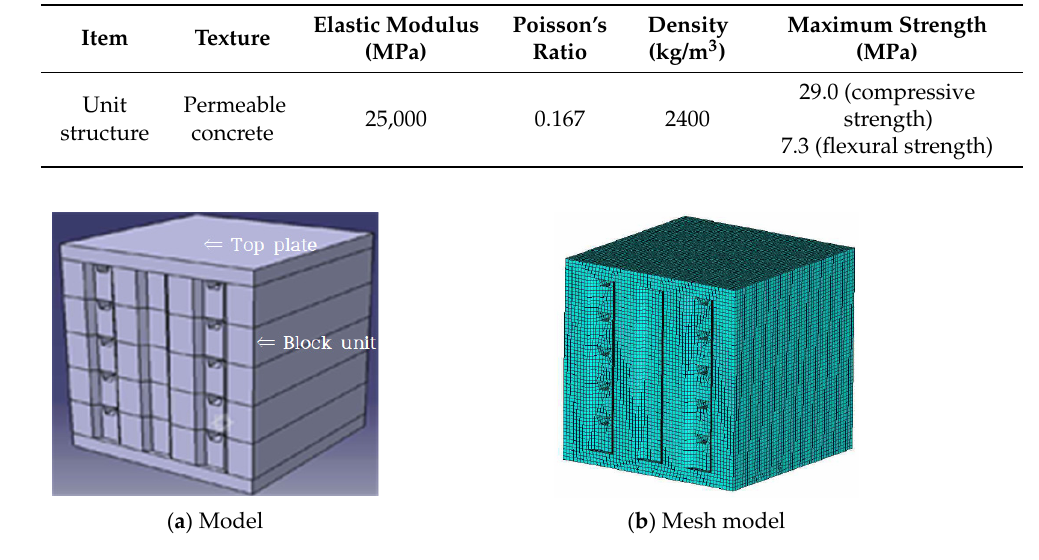
Figure 5. Test load conditions of the unit structure (Front and rear (earth pressure)/Top (overburden pressure 1 m + live load 600 kN)). Table 8. Material properties. Table 7. Analysis conditions.